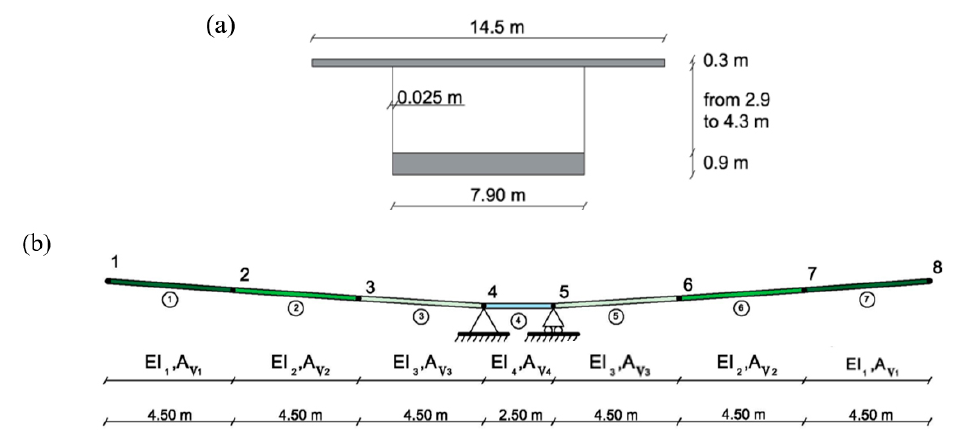
Figure 11. Yunbao Bridge: ( a ) cross-section and ( b ) finite element model (FEM). Table 3. Properties of the FEM of the bridge.